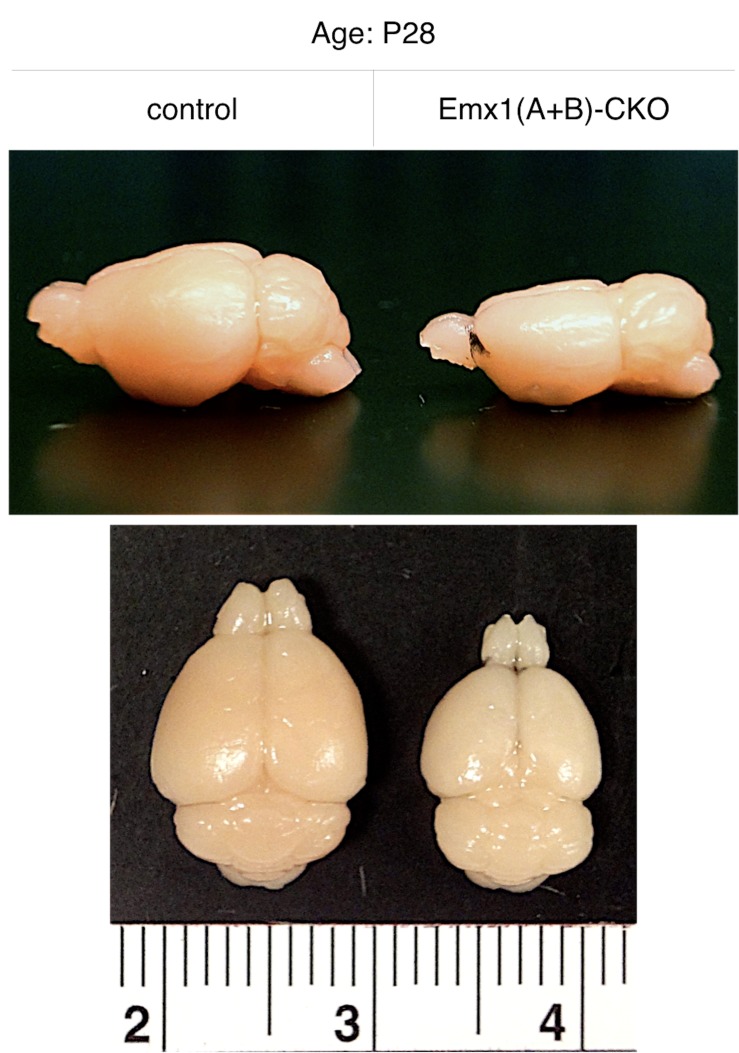
Emx1(A+B)-CKO neuropathological abnormalities that emerge postnatally are restricted to the forebrain.Gross morphology of Emx1(A+B)-CKO and control brains. Emx1(A+B)-CKO causes grossly apparent atrophy in the forebrain Cre field while hindbrain morphology appears unchanged.